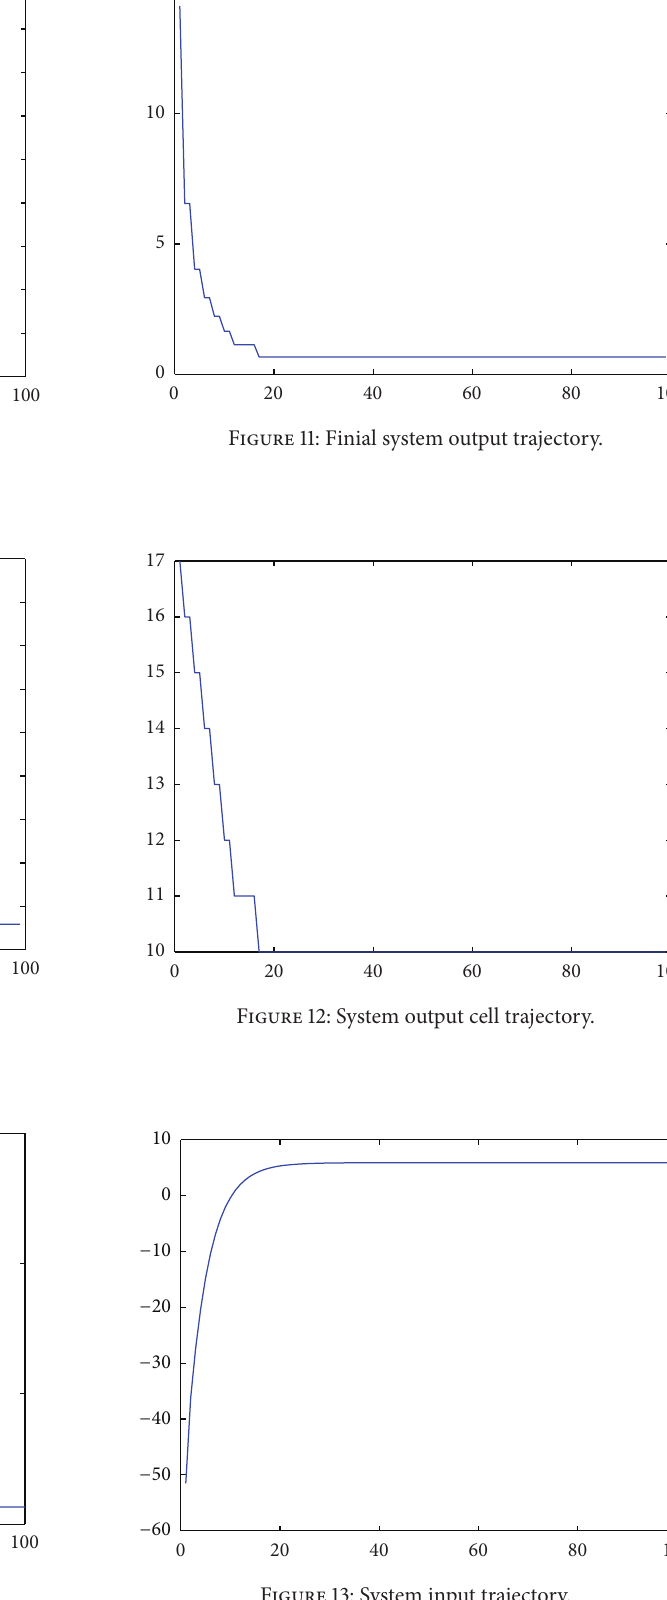
Figure 13: System input